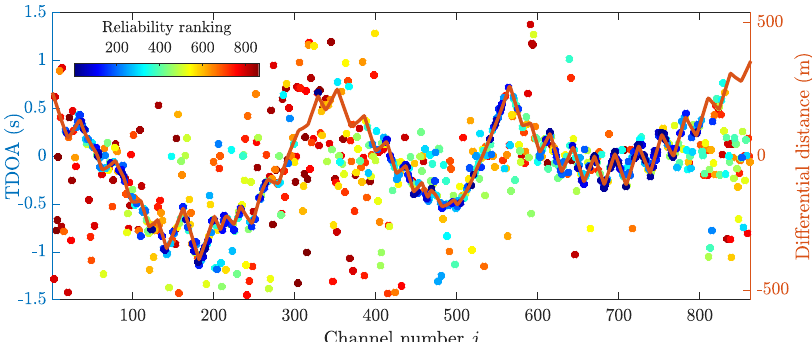
Fig. 3 Blind TDOA estimation. The blindly estimated time difference of arrivals (TDOAs) using the selected pilot trace and all the DAS data channels are compared with the non-blind differential distances calculated from the actual positions of the acoustic source and sensing fi bre. The distance to the selected pilot trace channel is subtracted to visually compare the relative distances and TDOAs with respect to the pilot channel. Since the wave propagation velocity v is unknown, TDOAs and distances cannot be compared with the same time or distance unit. The colour scale represents the blind reliability ranking. This ranking is composed so that the most reliable TDOA is ranked in the 1st place and the least reliable one in the